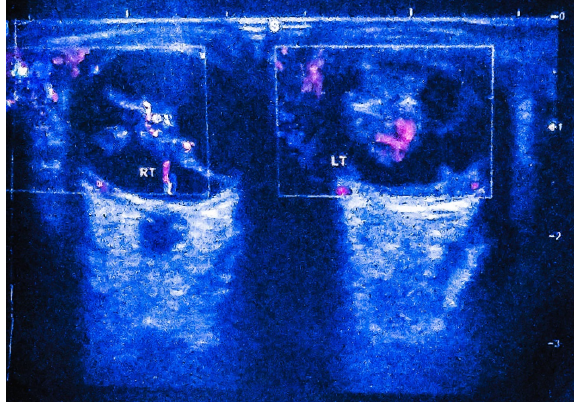
Figure 2: Color Doppler showing vascularity Case 2